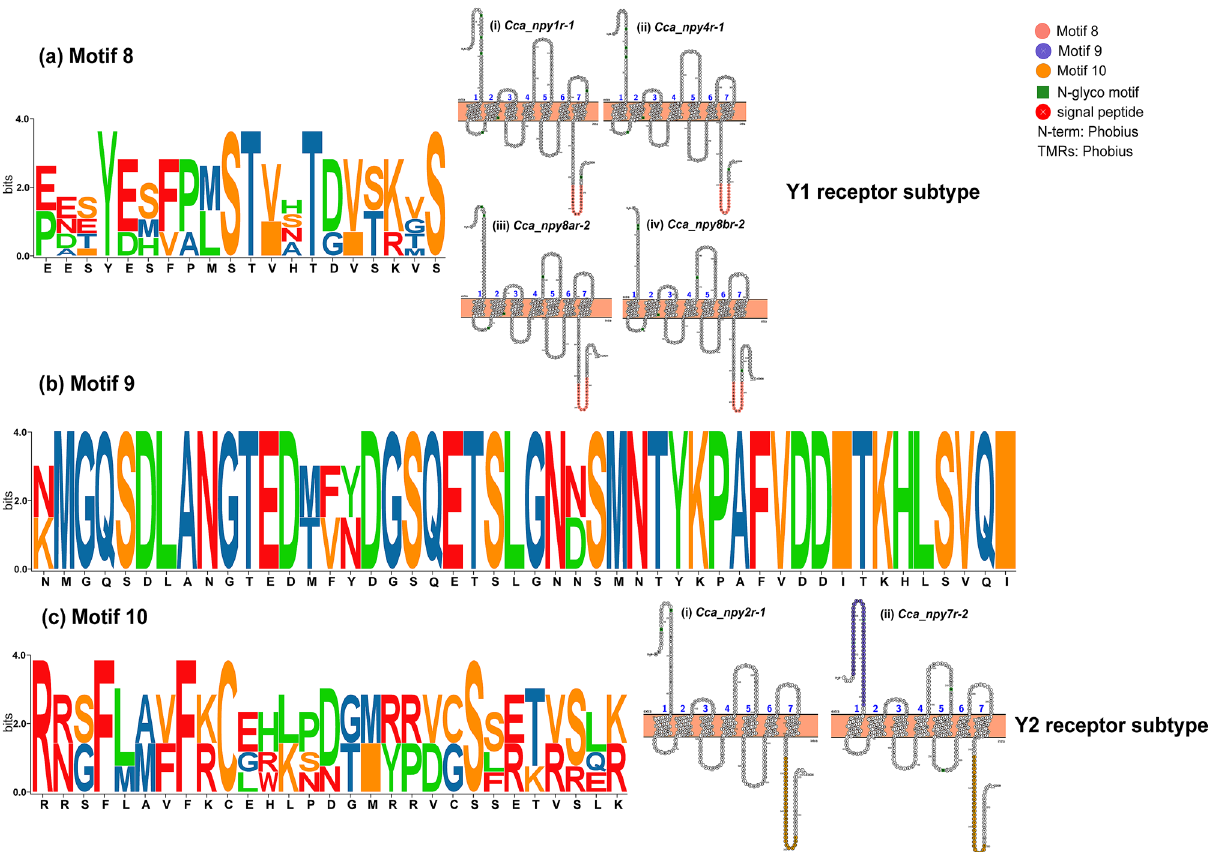
Figure 4. Structure and motif characteristics of two subtypes of NPY-family receptors in allotetraploid C. carpio . ( a ) Y1 subtype receptors in allotetraploid C. carpio and their common unique motif. Motif 8 is unique to the Y1 receptor subtype of C. carpio . On the left are a logo representation and distribution of motif 8 for the C. carpio NPY-family receptors. On the right are examples of four Y1 receptors ( Cca_npy1r-1 , Cca_npy4r-1 , Cca_ npy8ar-2 and Cca_npy8br-2 ), showing the distribution of motif 8 in transmembrane domains. ( b , c ) Y2 subtype receptors in allotetraploid C. carpio and their common unique motifs. Motif 9 is specific to the N-terminal of Y2 subtype receptors, while motif 10 is unique to the C-terminal of Y2 subtype receptors. On the left are logos representing the distribution of motif 9 and motif 10 for the C. carpio NPY-family receptors. On the right are